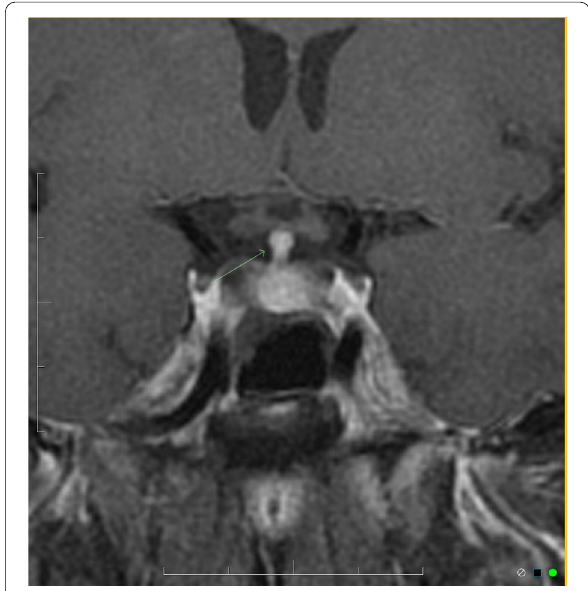
Fig. 2 MRI T1-weighted coronal view same non-enhancing 0.46 0.33 cm pituitary lesion ×